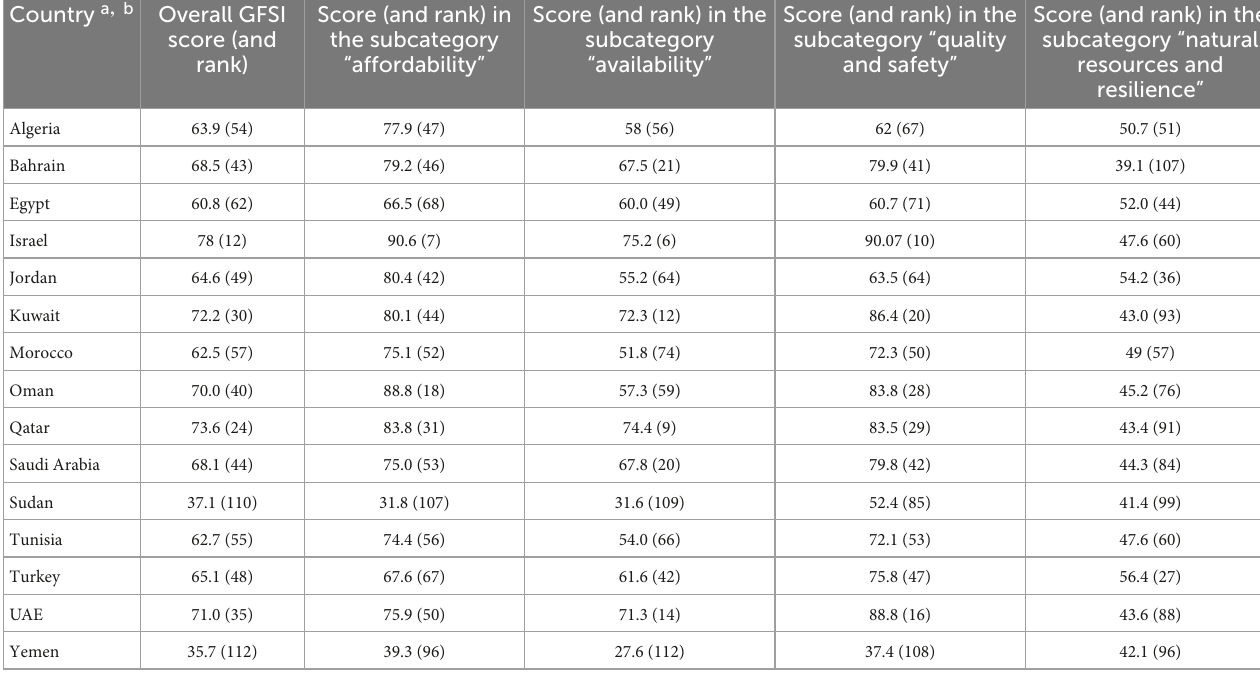
TABLE 3 Ranking of Middle Eastern countries in the Global Food Security Index (GFSI) 2021. Country a , b Overall